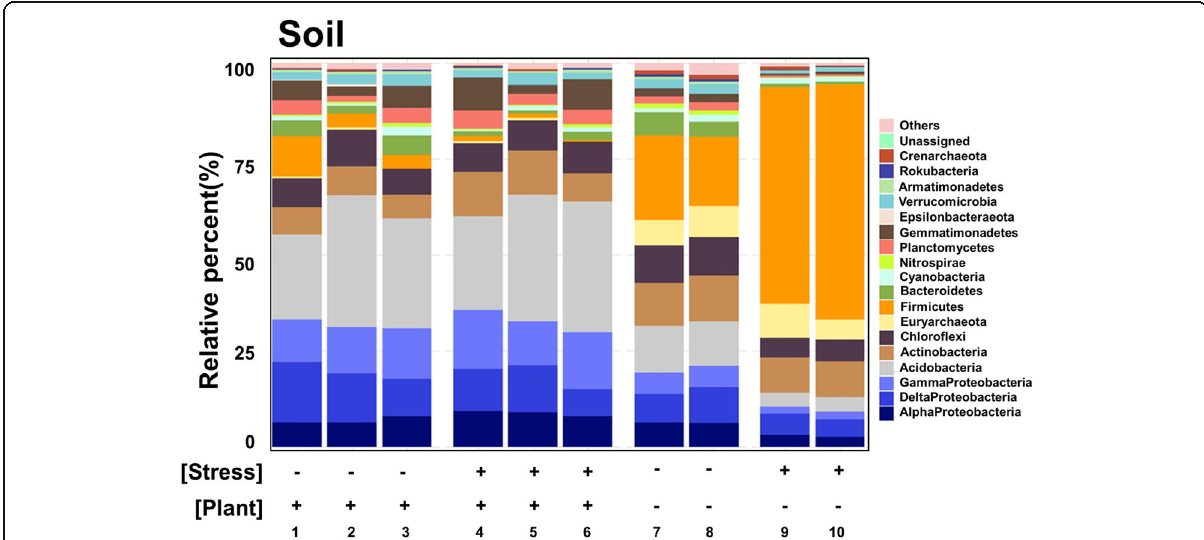
Fig. 2 Relative abundance of the 16 most abundant phyla from each soil sample collected from systems under drought stress or the presence of plants. The data points represent the abundance of each phylum relative to the total of all phyla in each sample. The 16 most abundant phyla in each treatment are integrated and identified, as well as an unassigned phylum. Only Proteobacteria is subdivided into classes. Clusters of other phyla are labeled as “ Others. ” Grids are set according to the application of stress (drought (+)/watered ( − )) and the presence of plants (with (+)/without ( − )). Detailed information on each sample is presented in Table